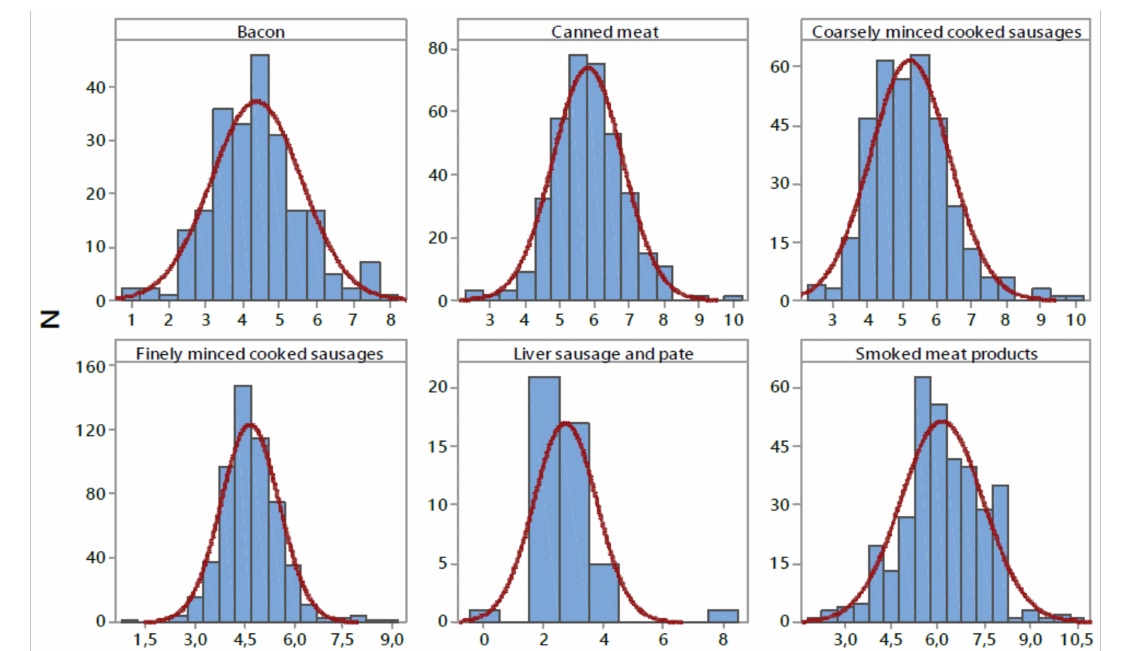
Figure 4. Distribution of phosphorus content (P 2 O 5 ) in examined processed meat products (g kg − 1 ). N—number of